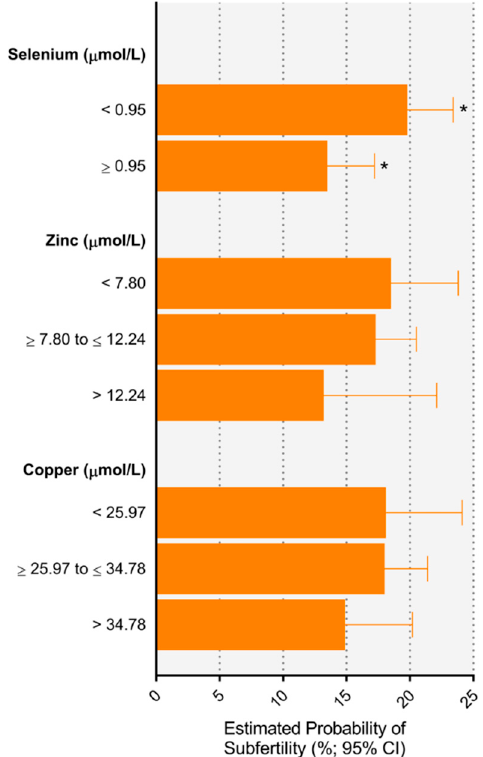
Figure 2. Estimated probability of subfertility according to maternal trace element concentration. * p < 0.05 between